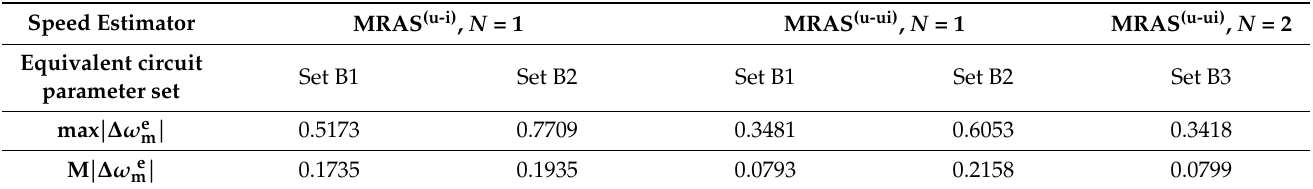
Table 1. Maximum and mean relative errors (%) of the speed estimation for the tested CR IM.